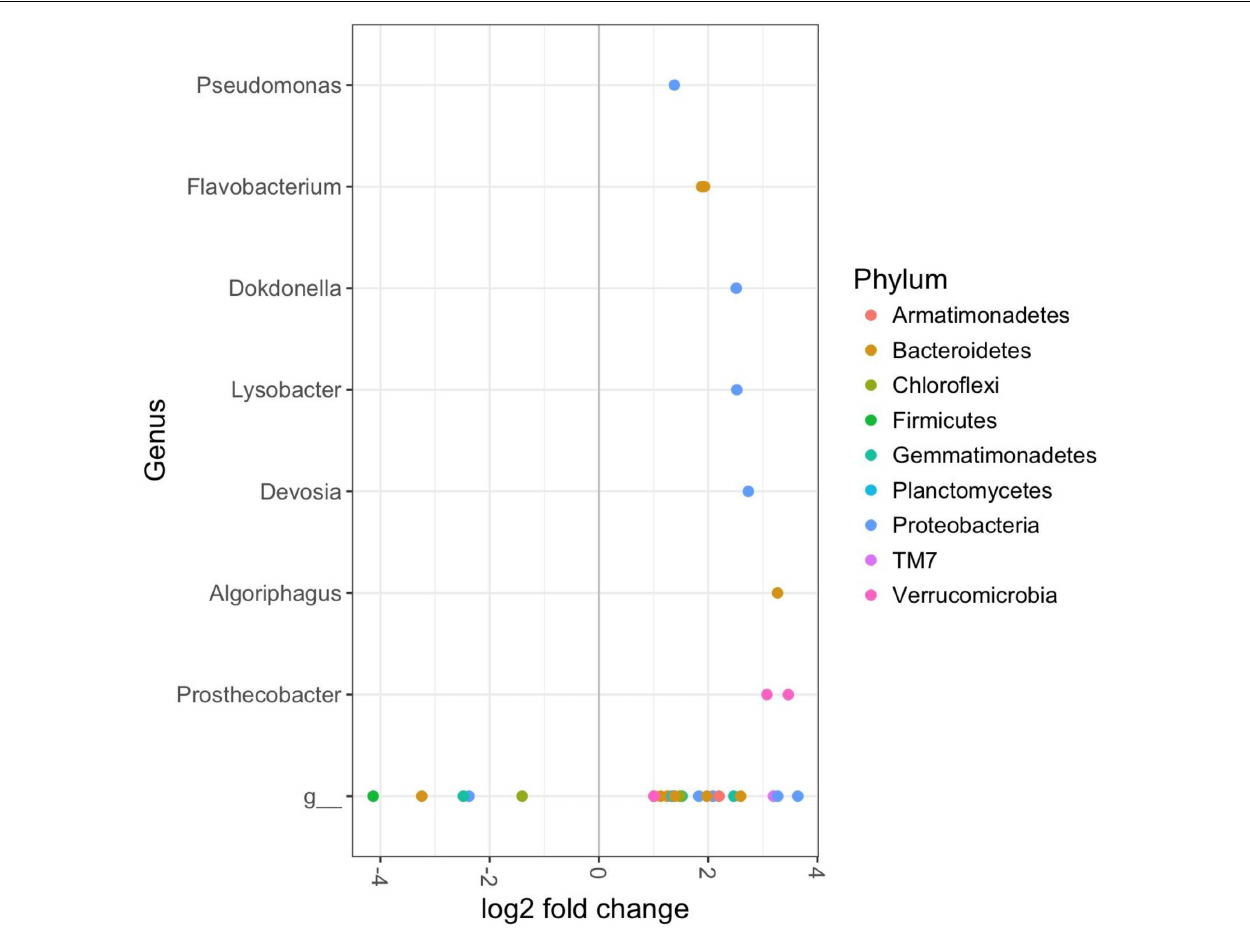
FIGURE 5 | DESeq2 analysis results indicating the fold-change of bacterial genera in rhizosphere soil bacterial communities of cabbages receiving synthetic fertilizer treatments (Low N and High N) relative to control cabbages at 12 weeks ( p < 0.01). Includes both aphid infested and uninfested plants as there were no significant effects of the aphids. “g” Represents taxa unclassified at the genus